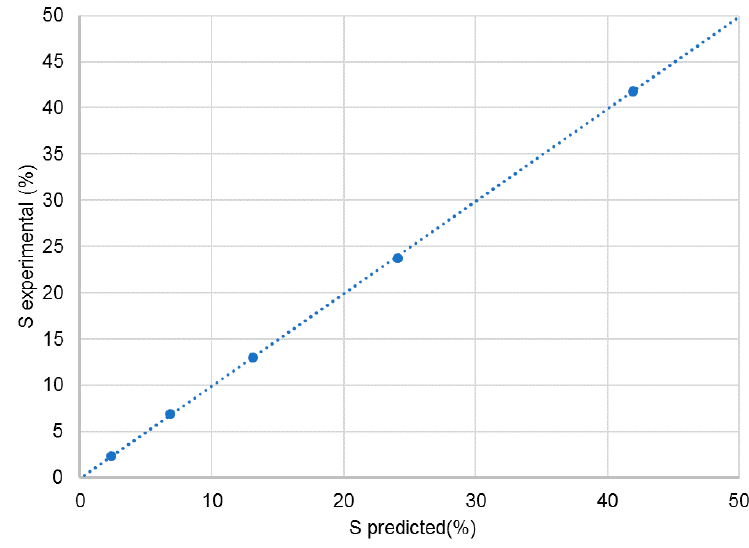
Figure 3. Percentage of S enantiomer by experiment versus predicted percentage.